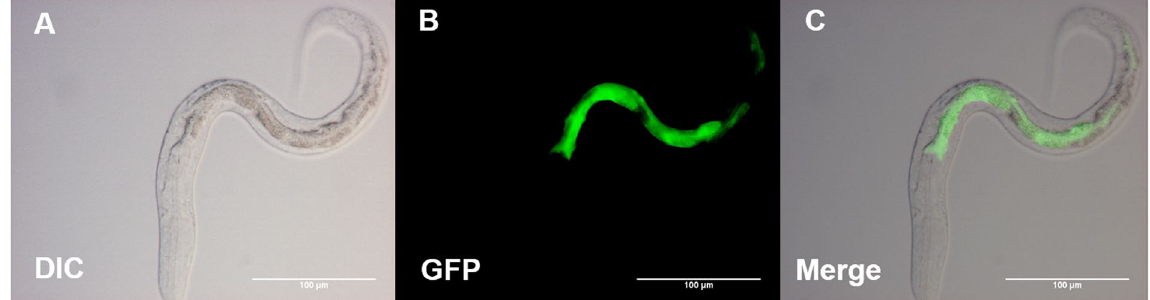
Figure 7. Representative expression pattern of GFP under the putative Ss-riok-2 promoter in a transgenic second-stage larva of Strongyloides stercoralis . Differential interference contrast (DIC) and fluorescence (GFP) images showing the expression of construct S. stercoralis Ss-riok-2p::gfp (pRP2; Fig. S1) in a post-free-living second-stage larva. GFP reporter expression predominated in intestine. Scale bars = 10 μ m.